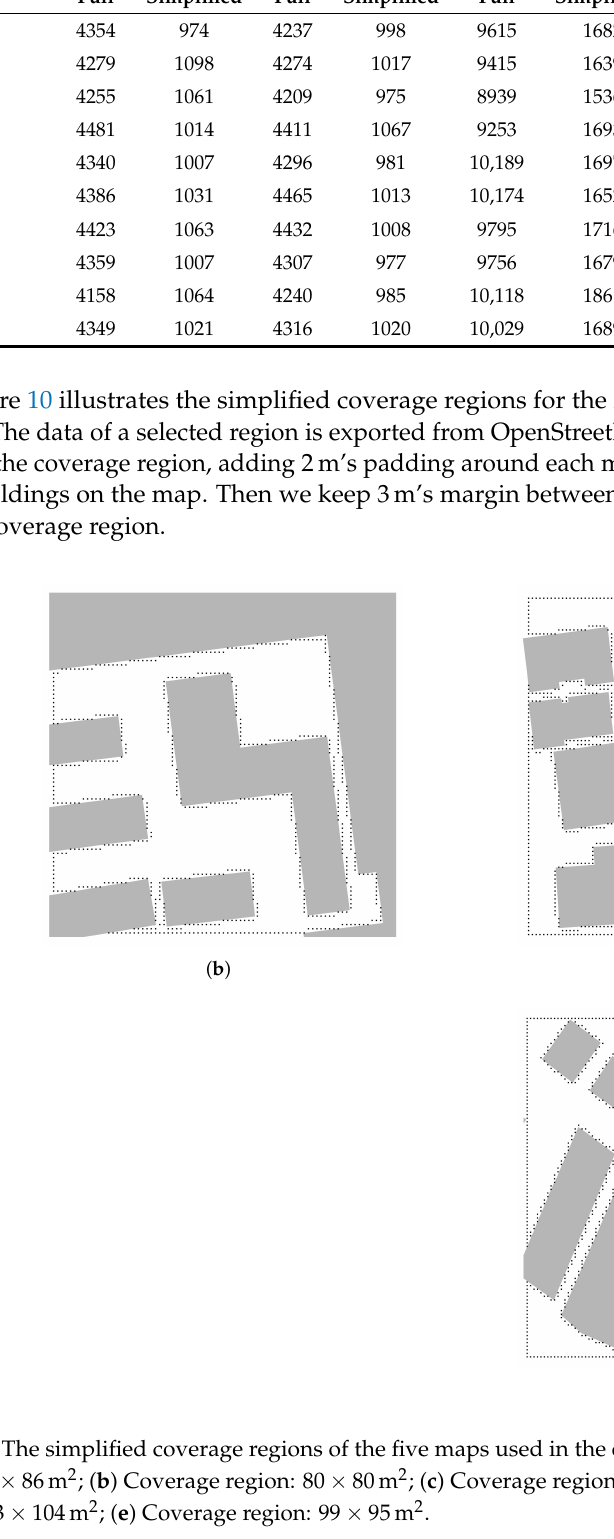
Table 3. Computation time (s) of RTS for evaluating all the channels for an AP placement considering the full or simplified coverage regions. Different AP placements, antenna types, and maps are tested in the experiments. The first column is for the indexes of AP placements. Map 1 Map 5 AP Placements Patch Isotropic